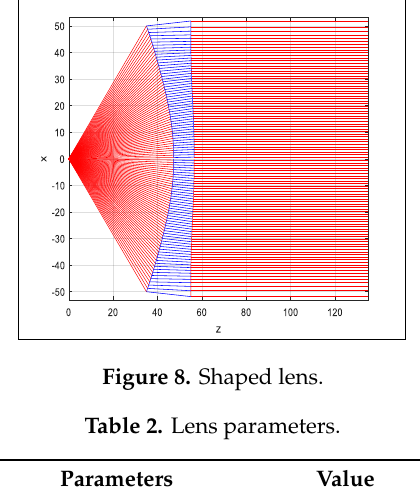
𝜃 𝑟 at each surface of the lens. The